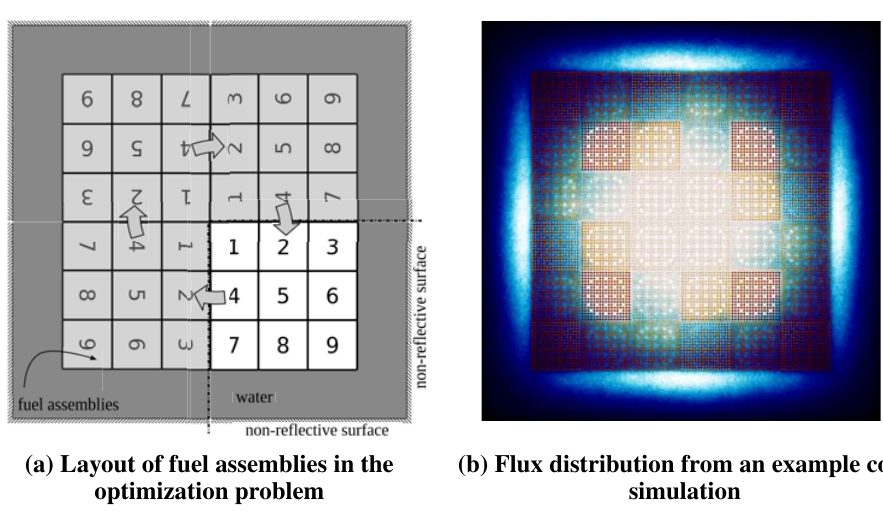
Figure 1: The ‘micro core’ used in this study